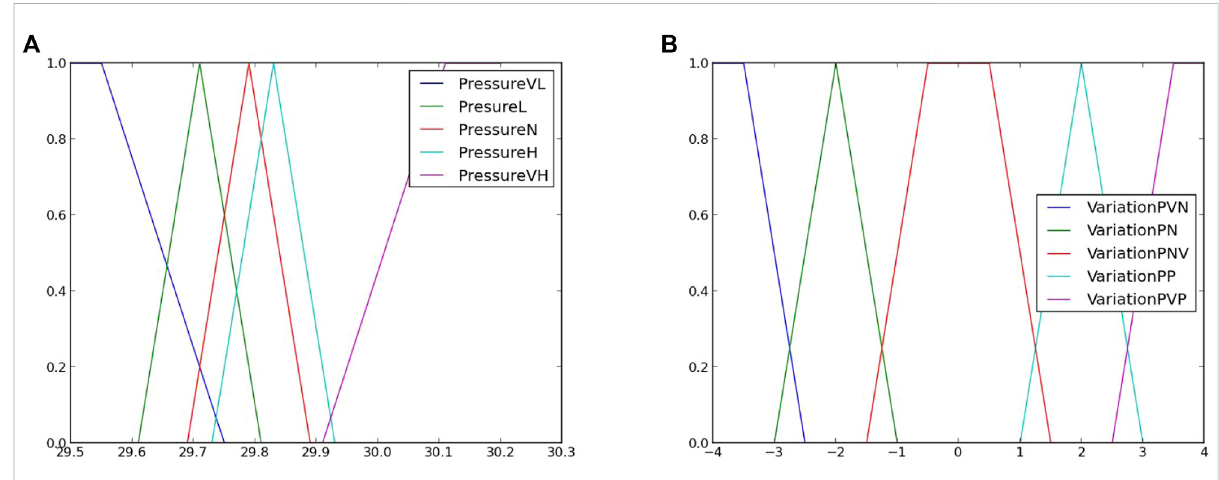
FIGURE 2 Pressure variable membership functions (A) . Pressure variation membership functions (B)